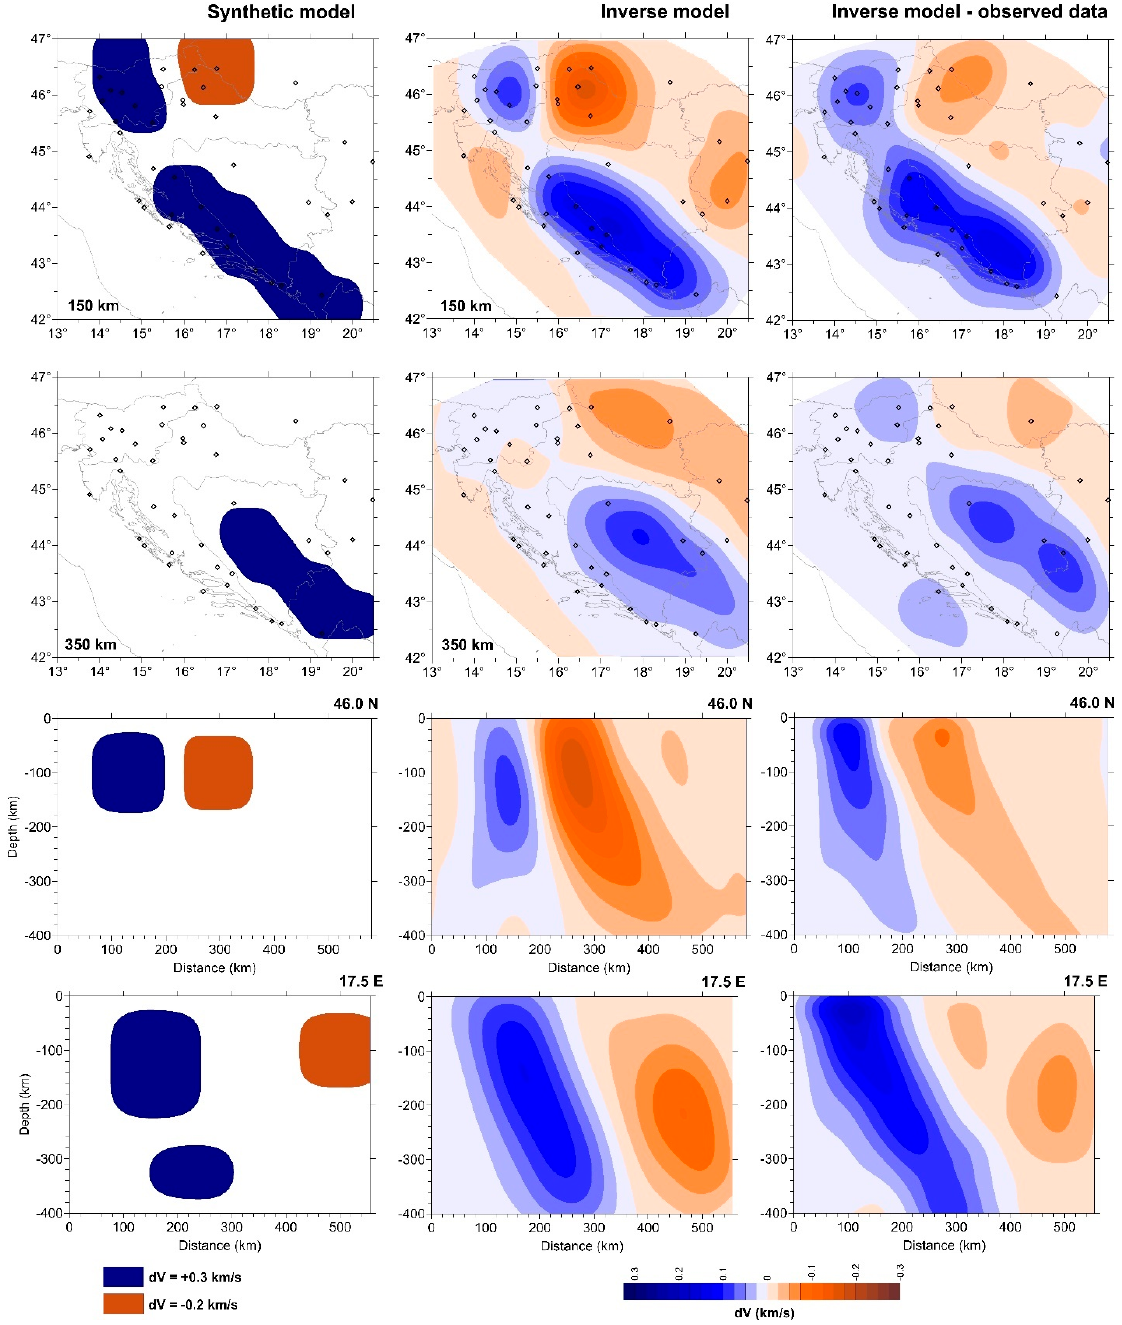
Figure 8. Fourth model. Three-dimensional velocity models showing two depth slices (150 km and 350 km, upper part) and two cross sections (46 °N and 17.5 °E, lower part). A narrow lateral discontinuity between the Northern and Central Dinarides and two separated blocks in the Southern Dinarides in the deep slab are assumed (left side). The inverse model recovered from synthetic travel-time residuals is shown in the middle part, and the inverse model of observed travel-time residuals in the SU-model [8] is shown on the right side. The shapes of the anomalies of the inverse model for synthetic data have a poor correlation with the shape of the anomalies of the inverse model for observed data, especially seen at depth slices. The slab breakage is pronounced as a discontinuation of the fast anomaly. Therefore, lateral discontinuities in the slab can be very efficiently determined due to good horizontal resolution. Damping of the fast anomaly in the observed model in the Northern Dinarides is the result of the slab geometry and applied seismic network, rather than slab